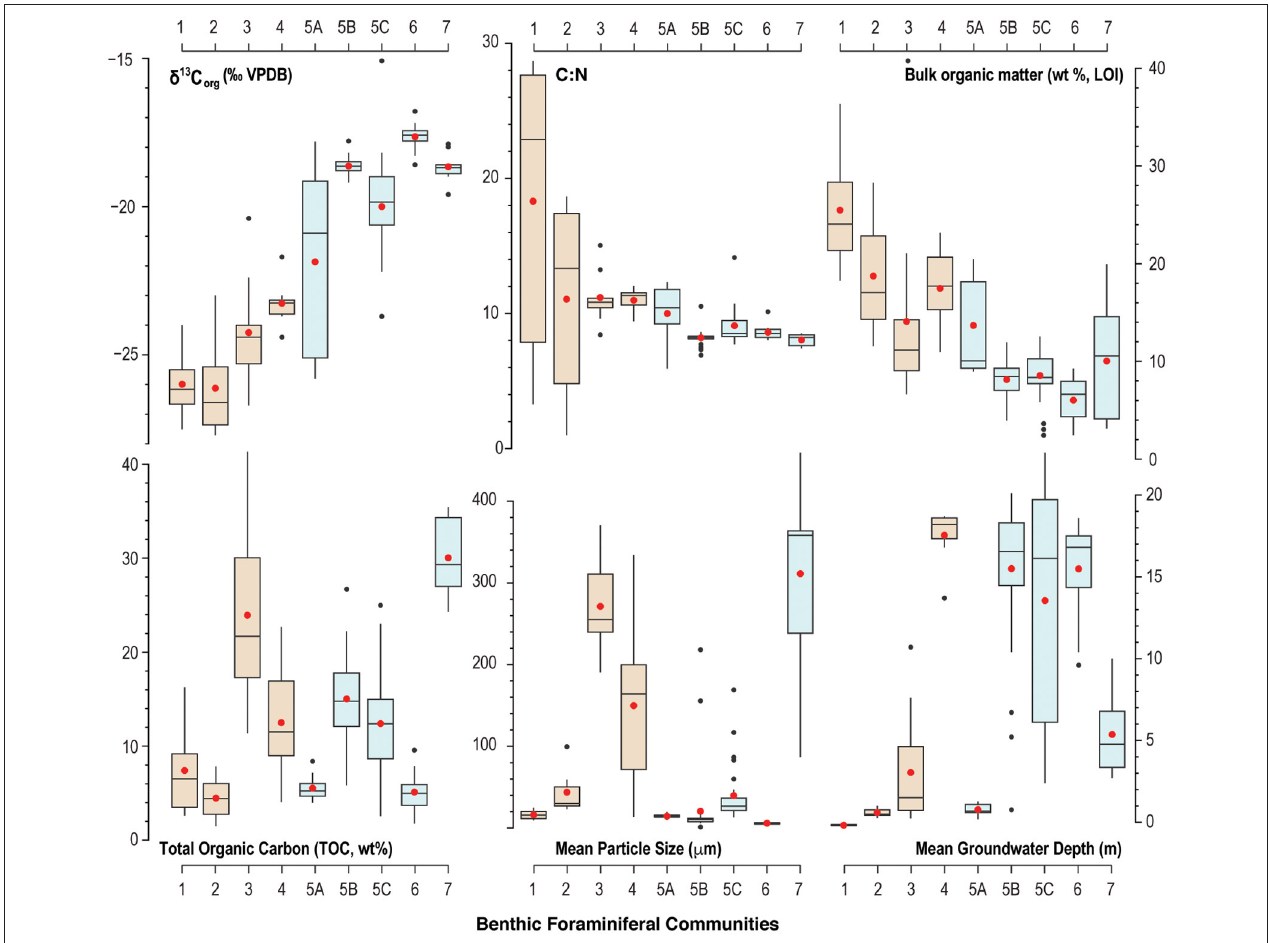
FIGURE 5 | Box-and-whisker plot of summary statistics (mean is red dot, median is central line) for benthic environmental characteristics associated with each benthic foraminiferal community. Despite the trend or gradient observed in δ 13 C org values, C:N ratios, and bulk organic matter content, the brown (blue) colored boxes identify benthic foraminiferal communities that prefer terrestrial (marine) organic matter sources delivered to the